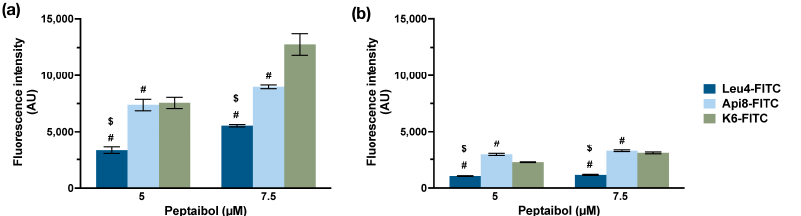
Figure 5. Flow cytometry measurements of FITC-conjugated peptaibols in MDA-MB-231 ( a ) and MCF-10 ( b ) cells after a 24 h incubation period. Data are expressed as mean percentage ± SD of at least two independent experiments, carried out in triplicate. #: p < 0.05, significantly different from K6-FITC, $: p < 0.05, significantly different from Api8-FITC (two-way ANOVA with Bonferroni ′ s correction).